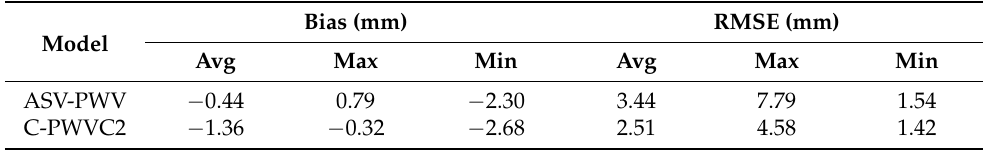
Table 1. Average annual bias and RMSE of the ASV-PWV and C-PWVC2 in